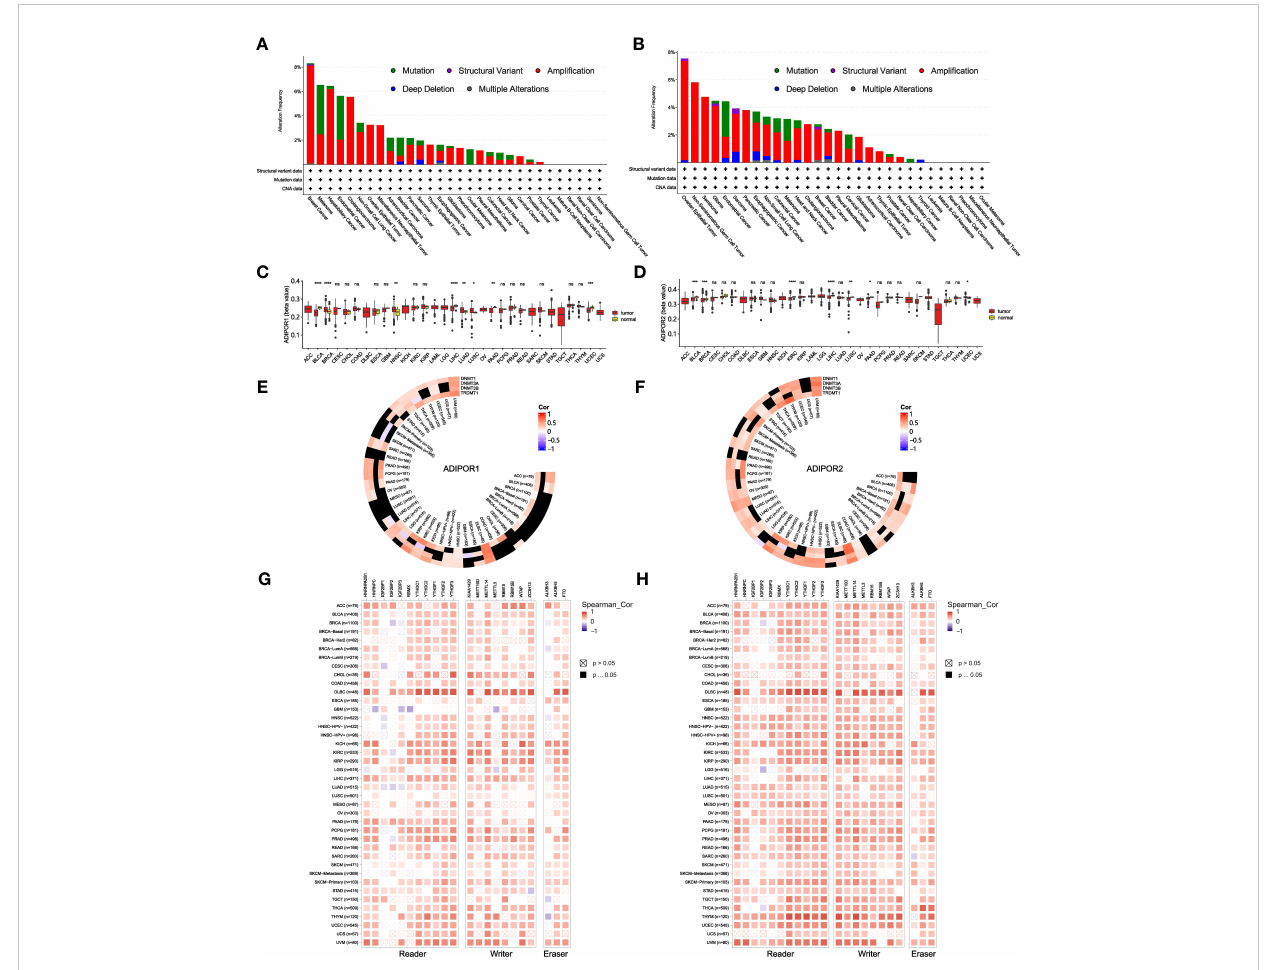
FIGURE 5 The genetic alteration and epigenetic modulation of ADIPOR1 and ADIPOR2. (A, B) The genetic alteration of ADIPOR1 and ADIPOR2 across cancers. (C, D) The DNA methylation of ADIPOR1 and ADIPOR2. (E, F) The correlation between ADIPOR1/2 and DNA methyltransferases. Black represented the relationship without signi fi cance. (G, H) The correlation between ADIPOR1/2 and m6A enzymes. *P < 0.05, **P < 0.01, ***P < 0.001, ****P < 0.0001 and ns presented P >